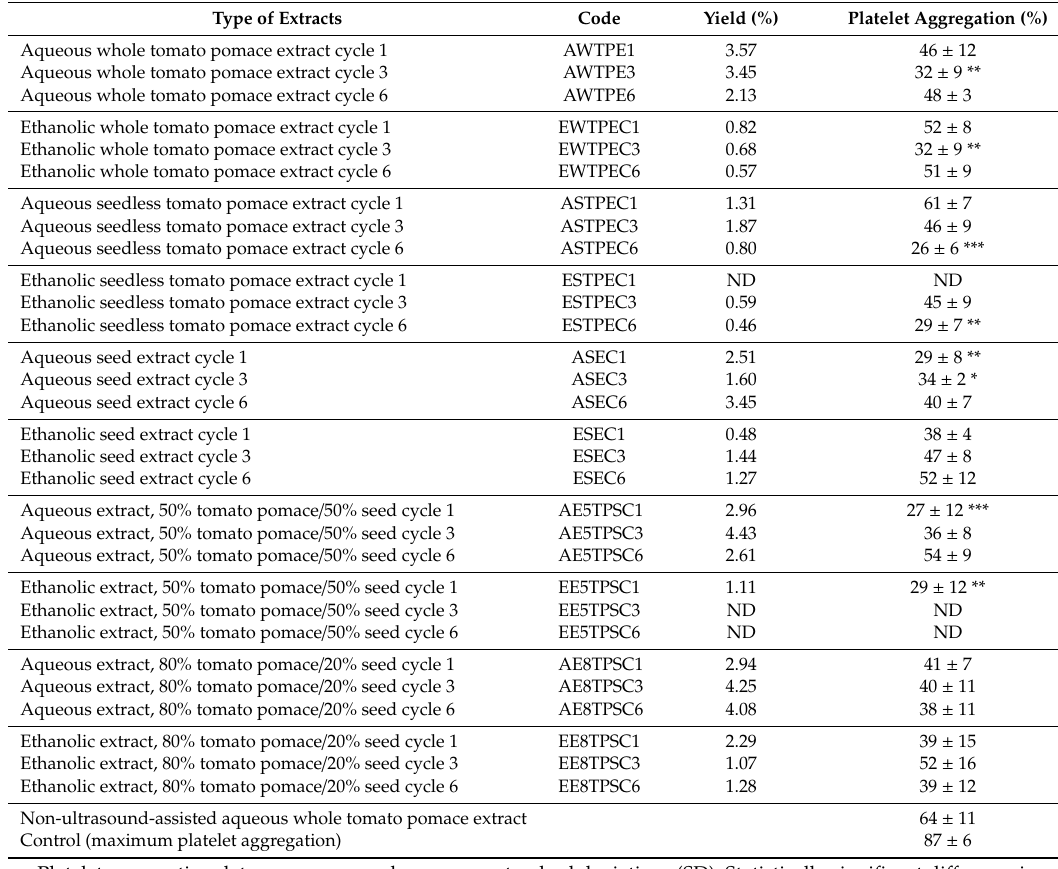
Table 1. Extraction yield and platelet anti-aggregant activity of di ff erent types of tomato pomace